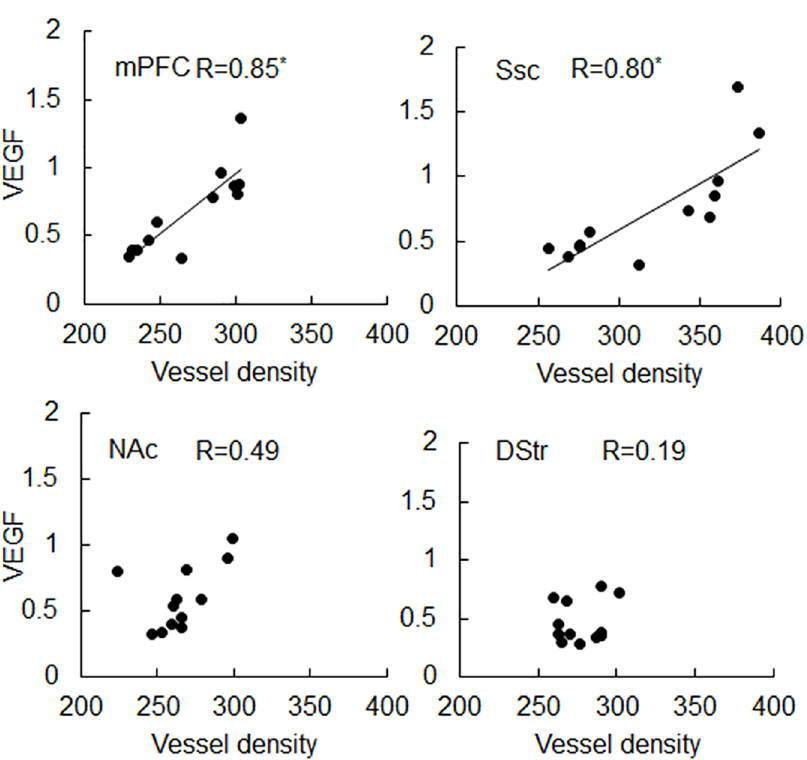
Fig 6. Correlations between VEGF expression and microvascular density in the middle prefrontal cortex (mPFC), the somatosensory cortex (Ssc), nucleus accumbens (NAc) and dorsal striatum (DStr). The Pearson product-moment correlationcoefficients(R) are listed on each panel. Significant ( P < 0.05)R values are marked with * . https://doi.org/10.1371/journal.pone.0175499.g006 PLOS ONE | https://doi.org/10.1371/journal.pone.0175499 April 27,